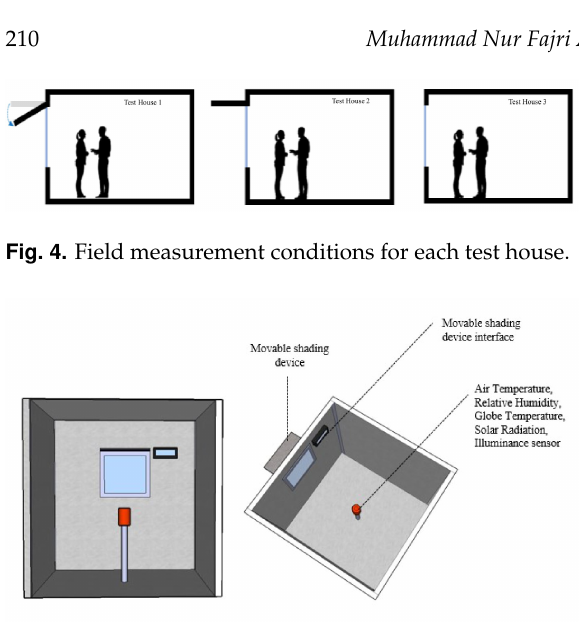
Fig. 5. Configuration of measurement instruments.